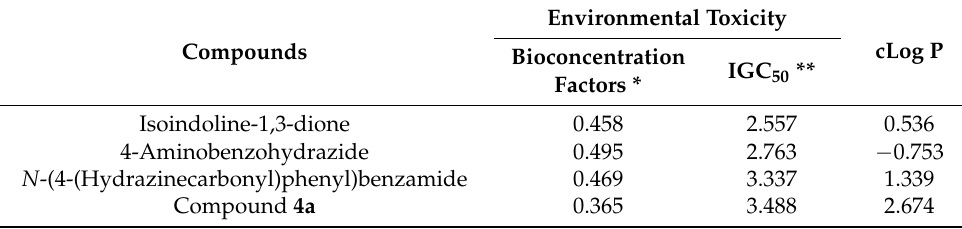
Table 1. The environmental toxicity values of compound 4a and the pioneering compounds. Compounds